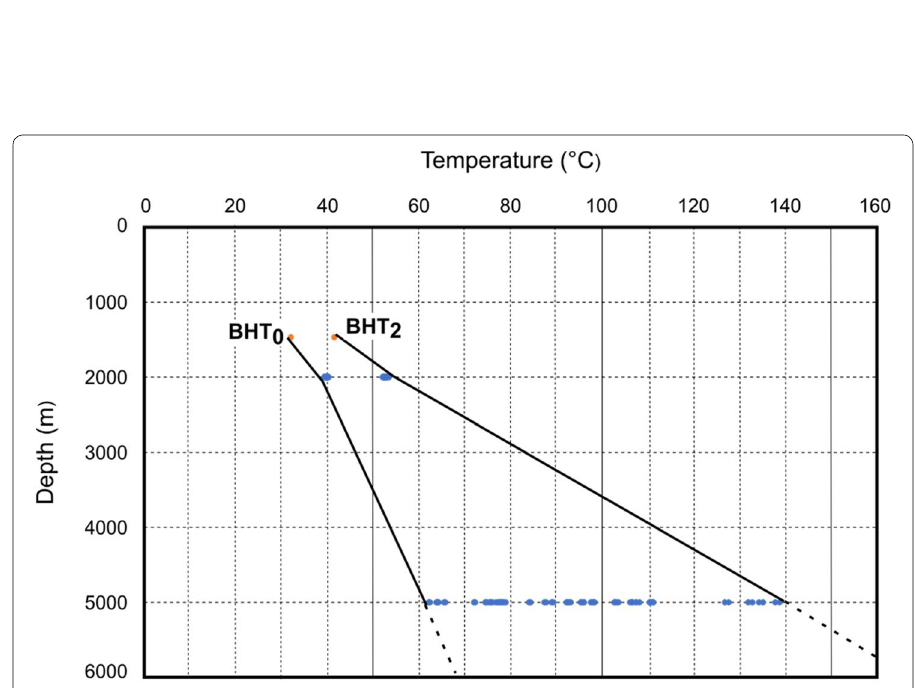
Fig. 13 1D cross‑sensitivity analysis between all thermal parameters for temperature evaluated at 2 and 5 km depth in well DZ017 using all possible combinations of pessimistic and optimistic scenarios. The orange points around 1400 m depth are the corrected and uncorrected BHT. Blue points represent computed temperature in the different